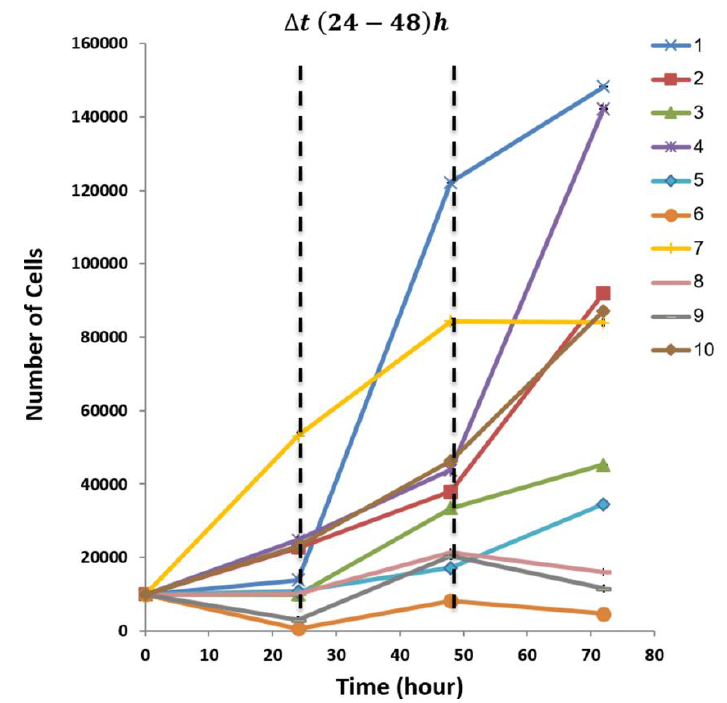
Figure 2. EPCs proliferation rate. Evaluation of the cell count was performed at four time points using XTT assay.